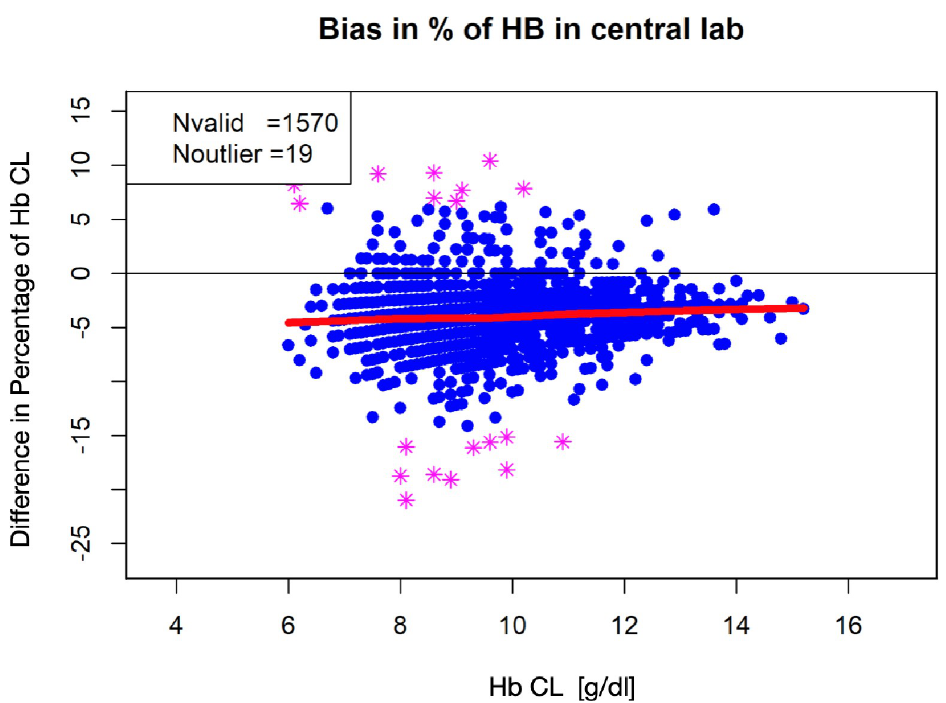
Fig 4. Bland-Altman Plot and LOWESS curve showing differences in percentage of Hb pairs (LIB-07 and LIB-26). The difference in percentage of Hb values (Hb-CL and Hb- BGA) calculated for each pair and plotted against the mean value of both measurements are displayed ((Hb-CL + Hb-BGA)/2). The LOWESS curve (red line) shows the tendency of mean bias expressed as percentage of CL Hb with lower Hb levels. Hb = hemoglobin, CL = central lab, BGA = blood gas analysis.